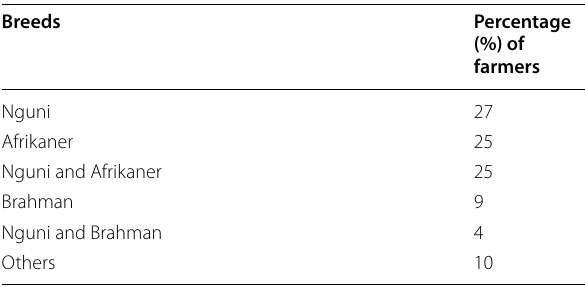
Table 3 Feed supplements commonly utilised by communal cattle farmers during the dry season in the Limpopo